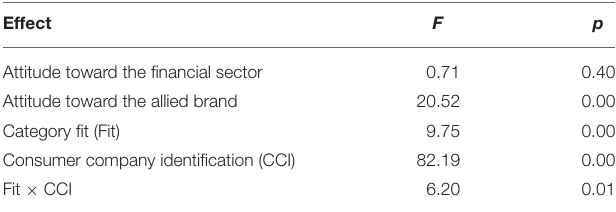
TABLE 5 | Study 1. ANCOVA results for purchase intention in the brand alliance